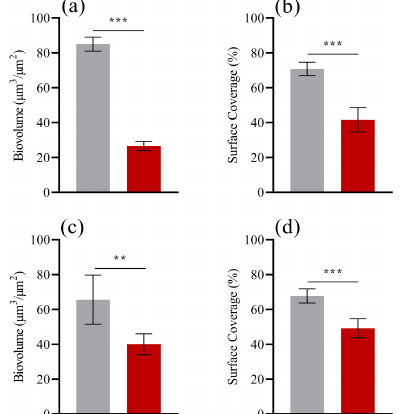
Figure 5. Biofilm structural parameters obtained from the z -stacks acquired at the confocal laser scanning microscopy (CLSM) after 49 days: biovolume ( a and c ) and surface coverage ( b and d ). Cyanobium sp. LEGE 10375 ( a and b ) and Pseudoalteromonas tunicata ( c and d ) biofilms formed on EpoRef ( ■ ) and SilRef ( ■ ) surfaces. Standard deviations for three independent experiments are presented. Statistical analysis was performed by using paired t -test, and significant differences between two surfaces are indicated with *** ( p < 0.01) and ** ( p < 0.05).